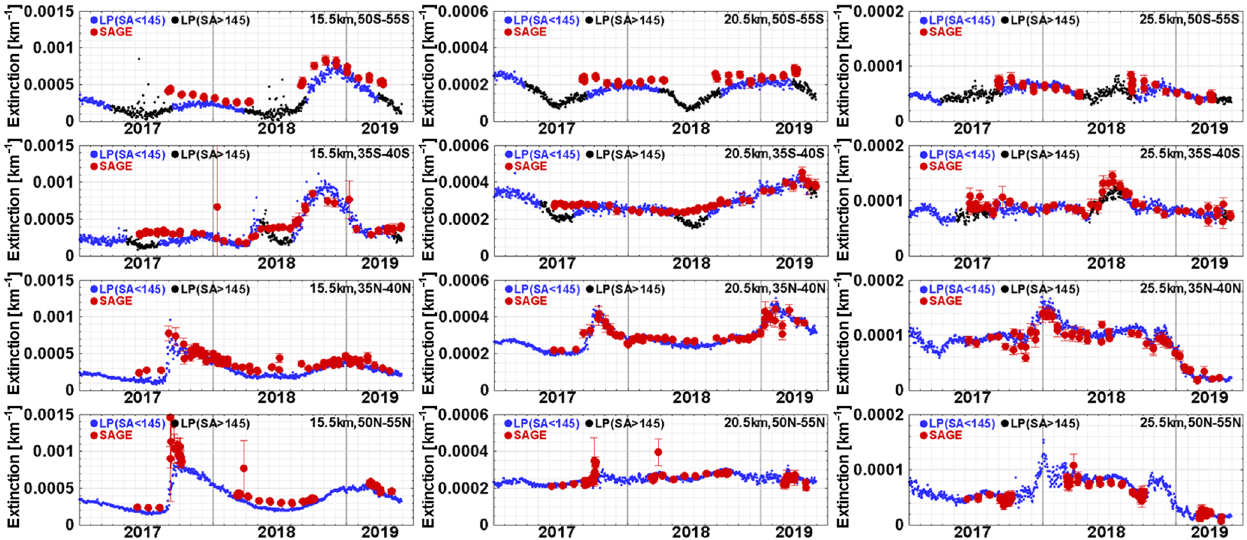
Figure 5. Same as Fig. 4 but for altitudes at 15.5km (left), 20.5km (middle), and 25.5km (right) for latitude bands outside the tropics angles (SA) less than 145 ◦ and greater than 145 ◦ , respectively. The LP extinction below 20km at southern latitudes (35–55 ◦ S) shows the presence of erroneous seasonal variations due to the lack of sensitivity to aerosol when the SA is greater than 145 ◦